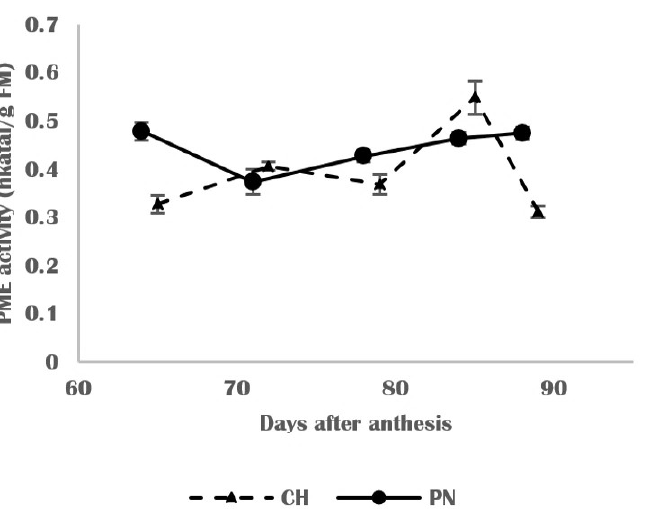
Figure 9. PME activity in grape skin from Pinot noir ( • ) and Chardonnay ( (cid:78) ) grapes during ripening. Means of 3 replications ±